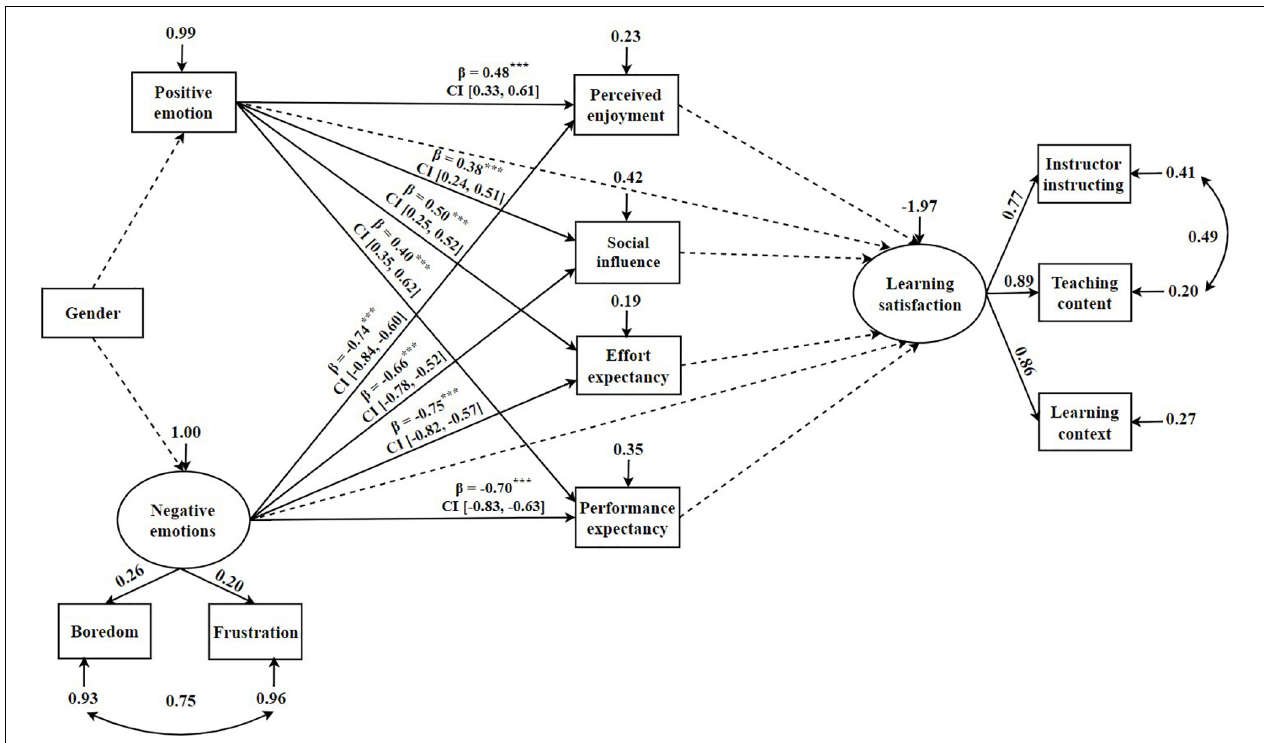
FIGURE 3 | Mediation model for the effects of academic emotions on learning satisfaction through the four dimensions of technology acceptance. The solid arrow represents the significant path, and the dotted arrow represents the insignificant path. β is the path coefficient. CI, confidence interval. *** p < 0.001.